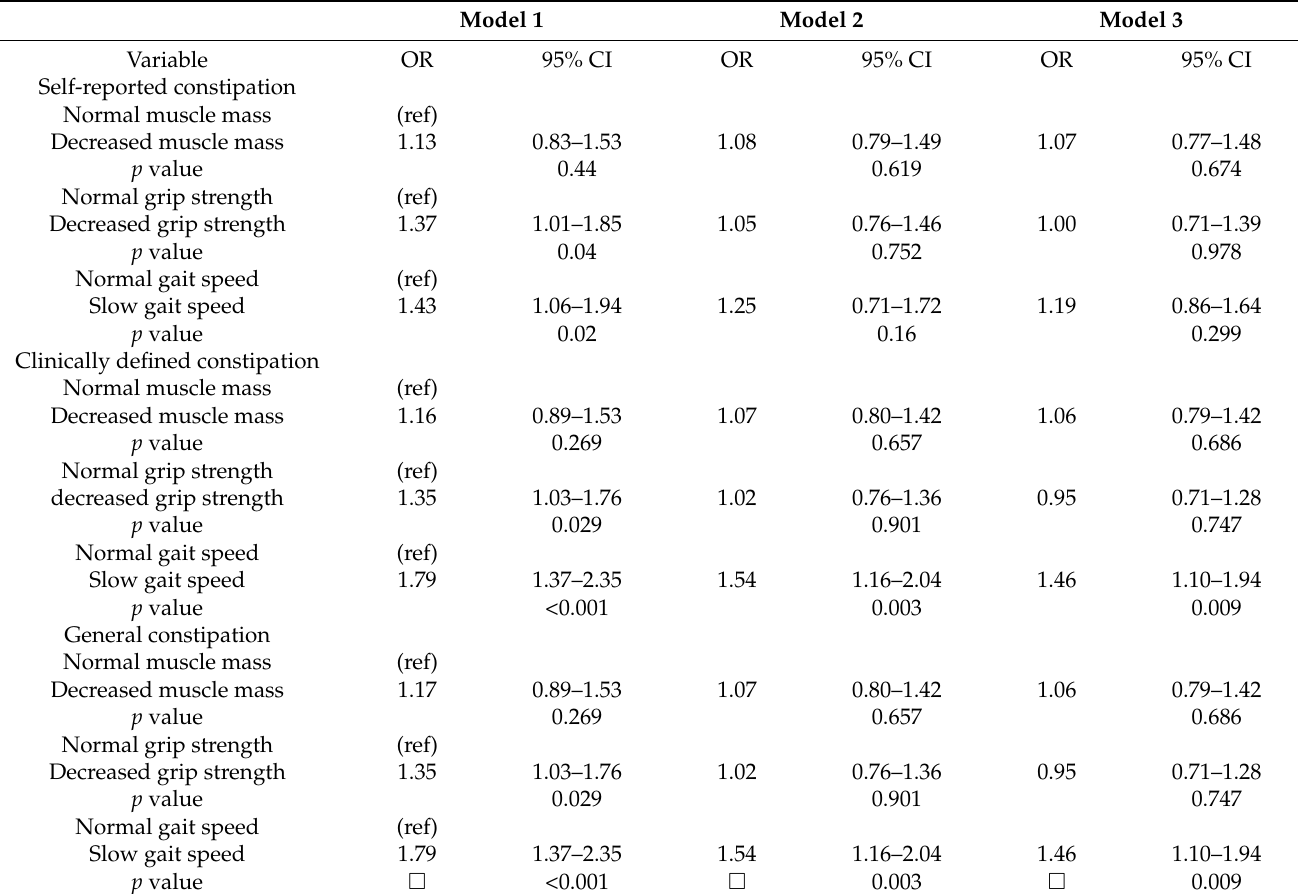
Table 5. Association of sarcopenia parameters with constipation